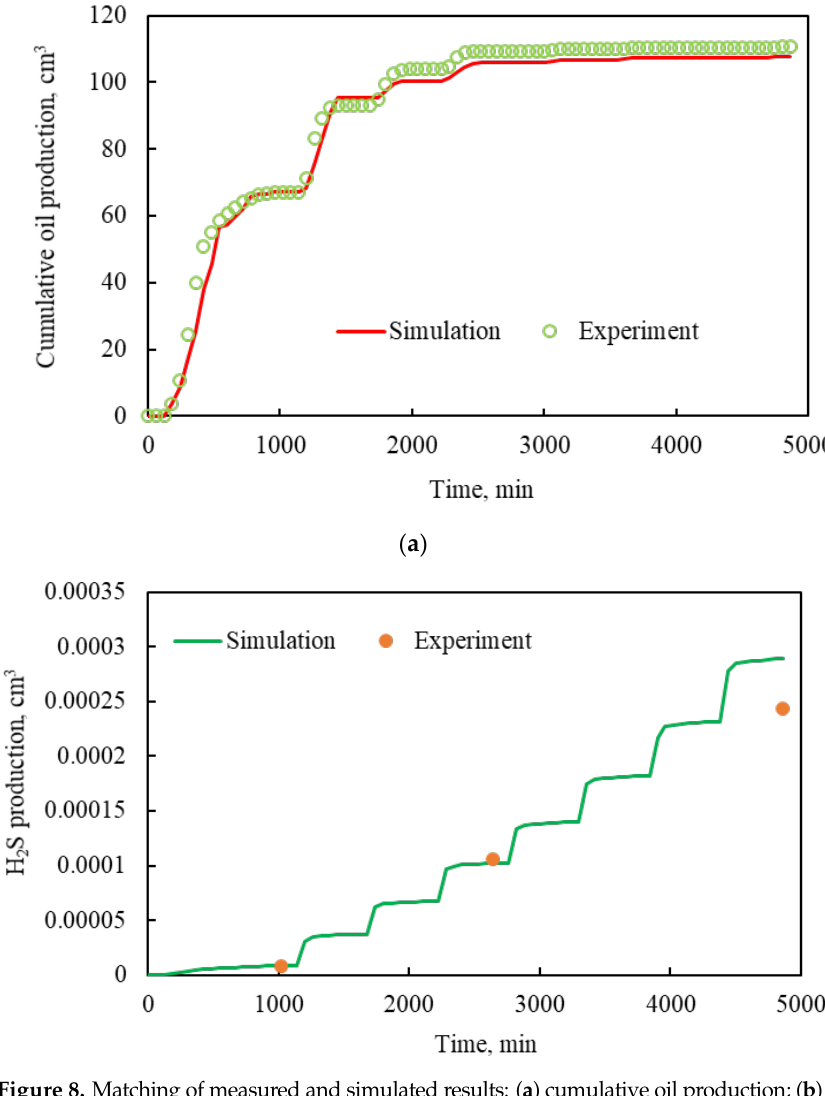
Figure 8. Matching of measured and simulated results: ( a ) cumulative oil production; ( b ) H 2 S pro- duction.